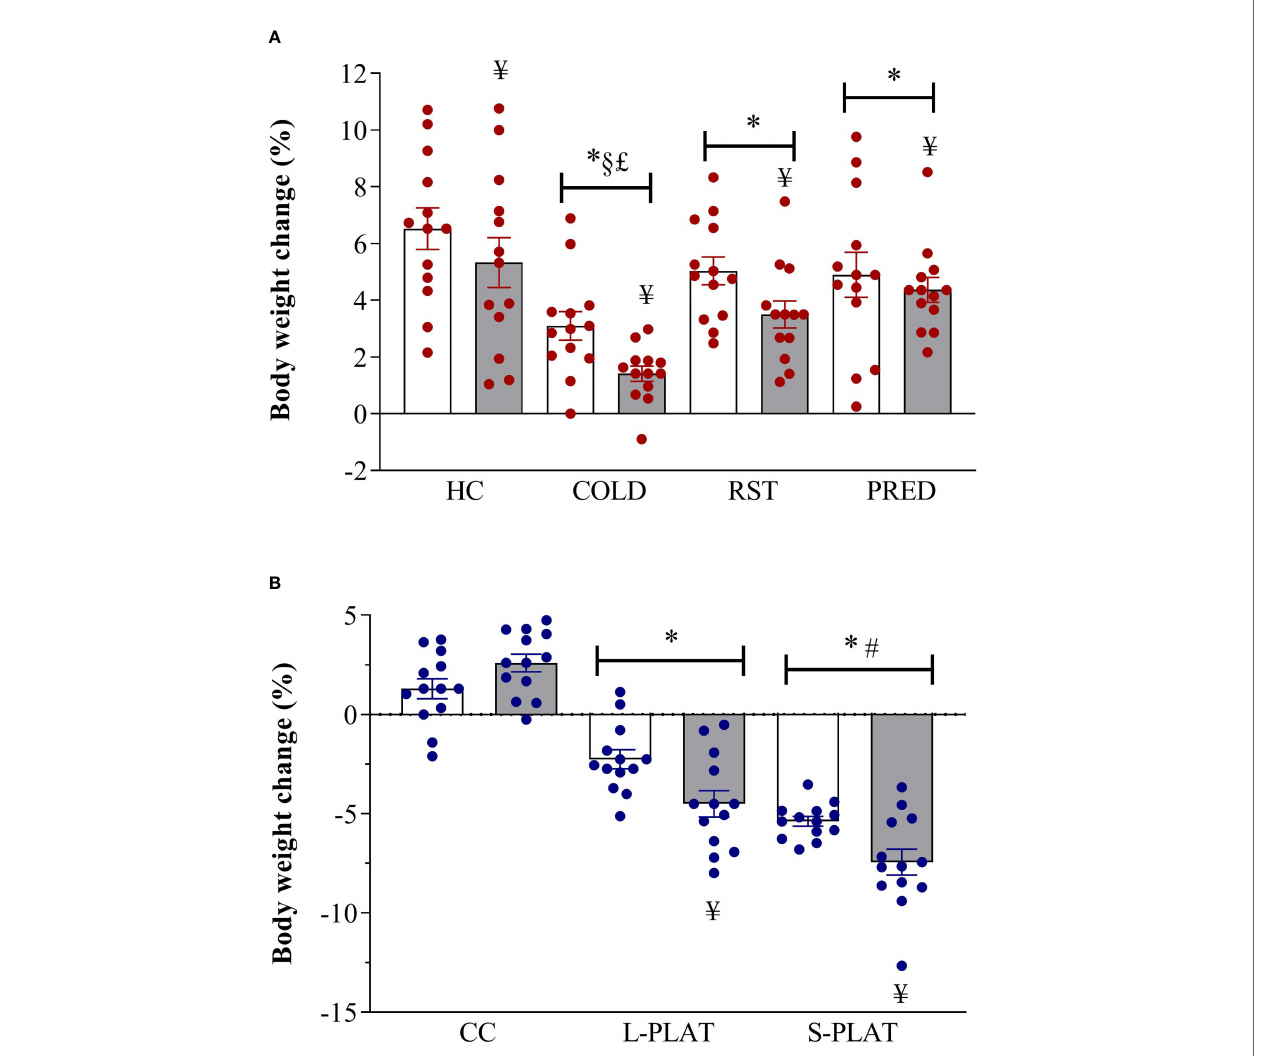
FIGURE 1 | (A) Effect of different stressors and (B) of PSD on body weight change. Data were plotted with individual values and the columns represent the mean ± SEM of 13 animals/subgroup. HC, home cage; RST, restraint stress; PRED, predator odour; CC, container control; L-PLAT, large platform; S-PLAT, small platform. White columns represent single or 1-day exposure and grey columns, repeated or 4-day exposure. * = different from respective control group; § = different from RST group; £ = different from PRED group; # = different from L-PLAT group; ¥ - different from single or from 1-day